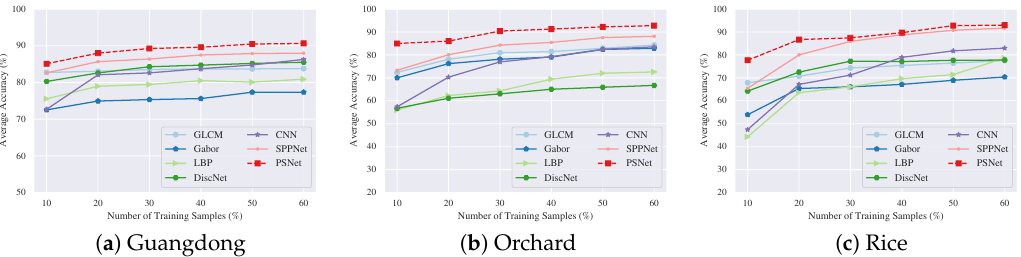
Figure 10. Average accuracy achieved on the validation set at different number of training samples.